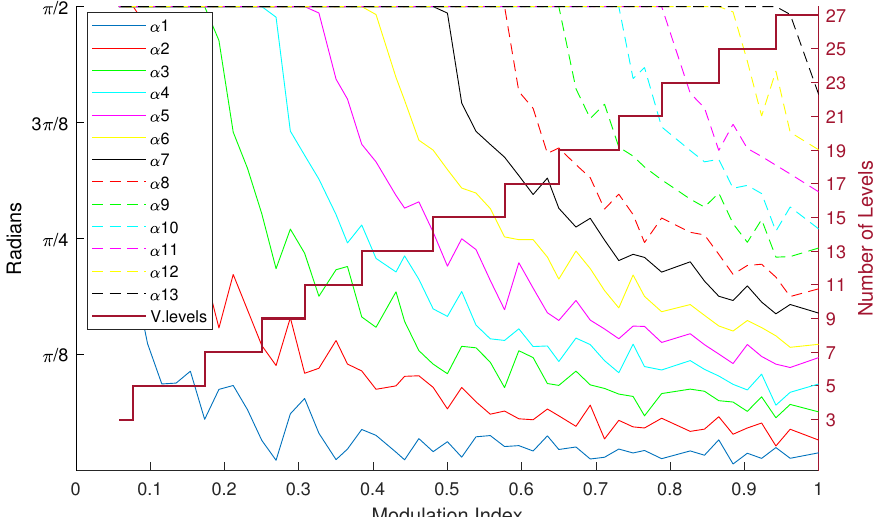
Figure 7. Switching angles for modulation index